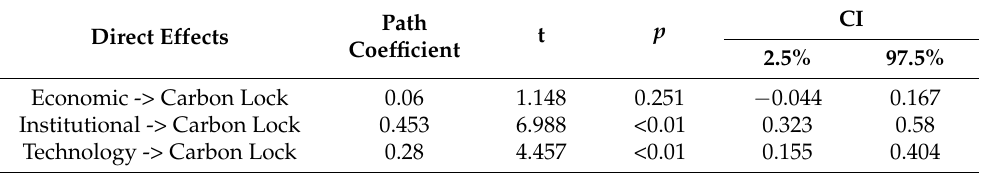
Table 8. Results from the structural model.